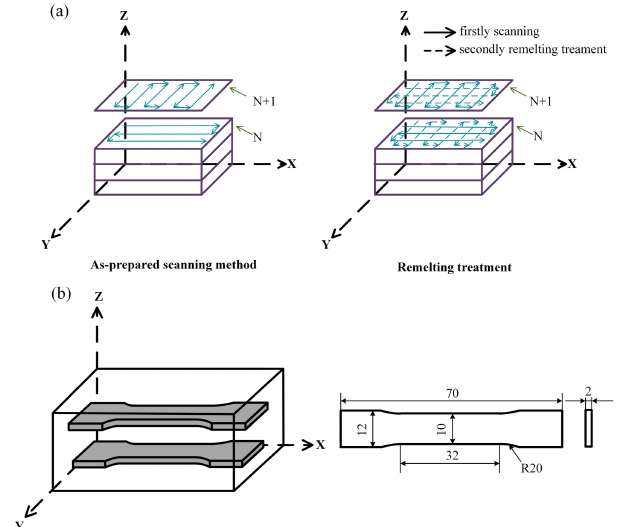
Figure 2. Schematic illustrations showing: ( a ) Deposition methods used to fabricate the samples by laser metal deposition (LMD); ( b ) Tensile test directions and dimensions of the tensile